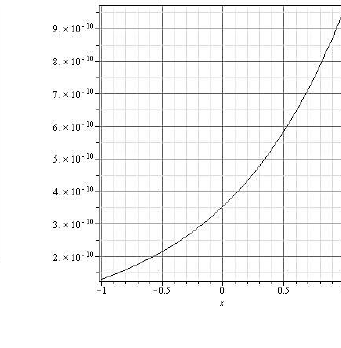
Figure 2. Absolute error of Example 4 ( k = 7).